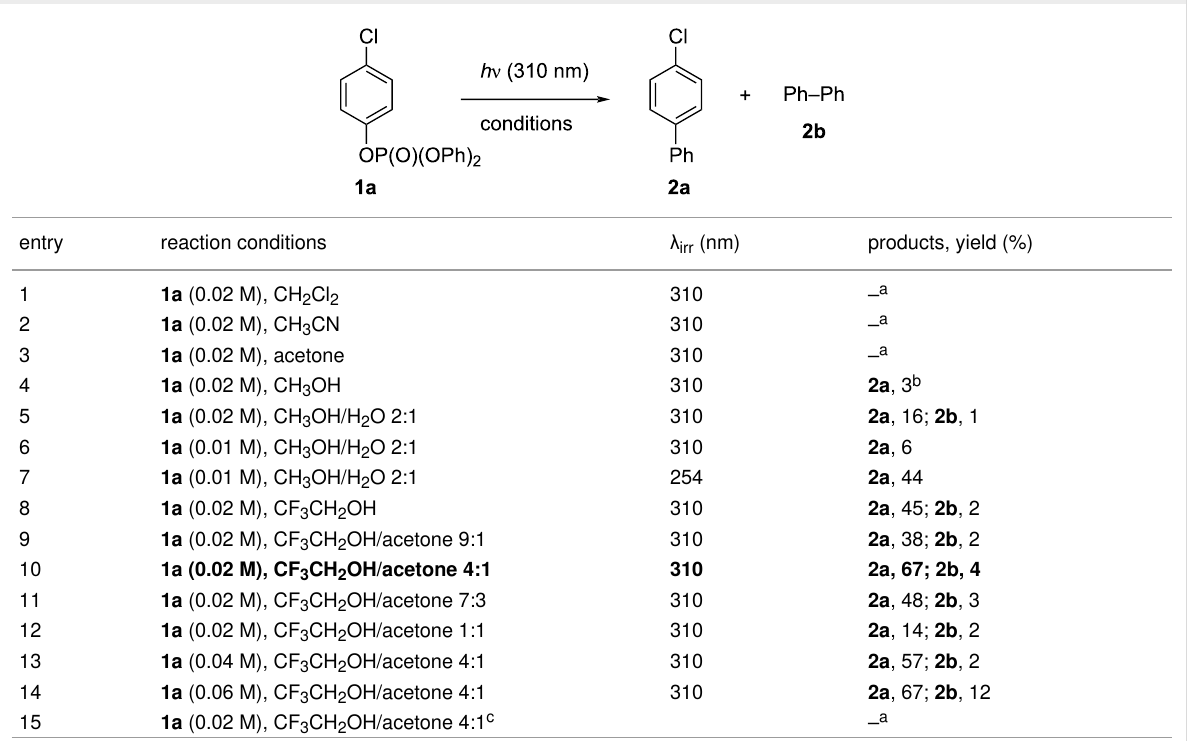
Table 1: Optimization of the reaction